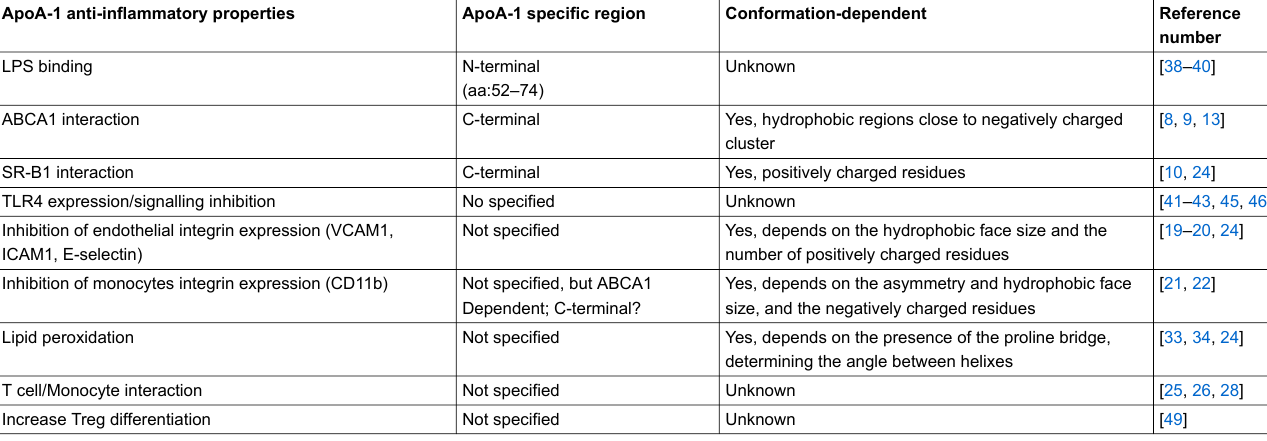
Table 1: Summary of apolipoprotein A-1 (apoA-1) related anti-inflammatory properties in relation with apoA-1 specific regions and conformation. ApoA-1 anti-inflammatory